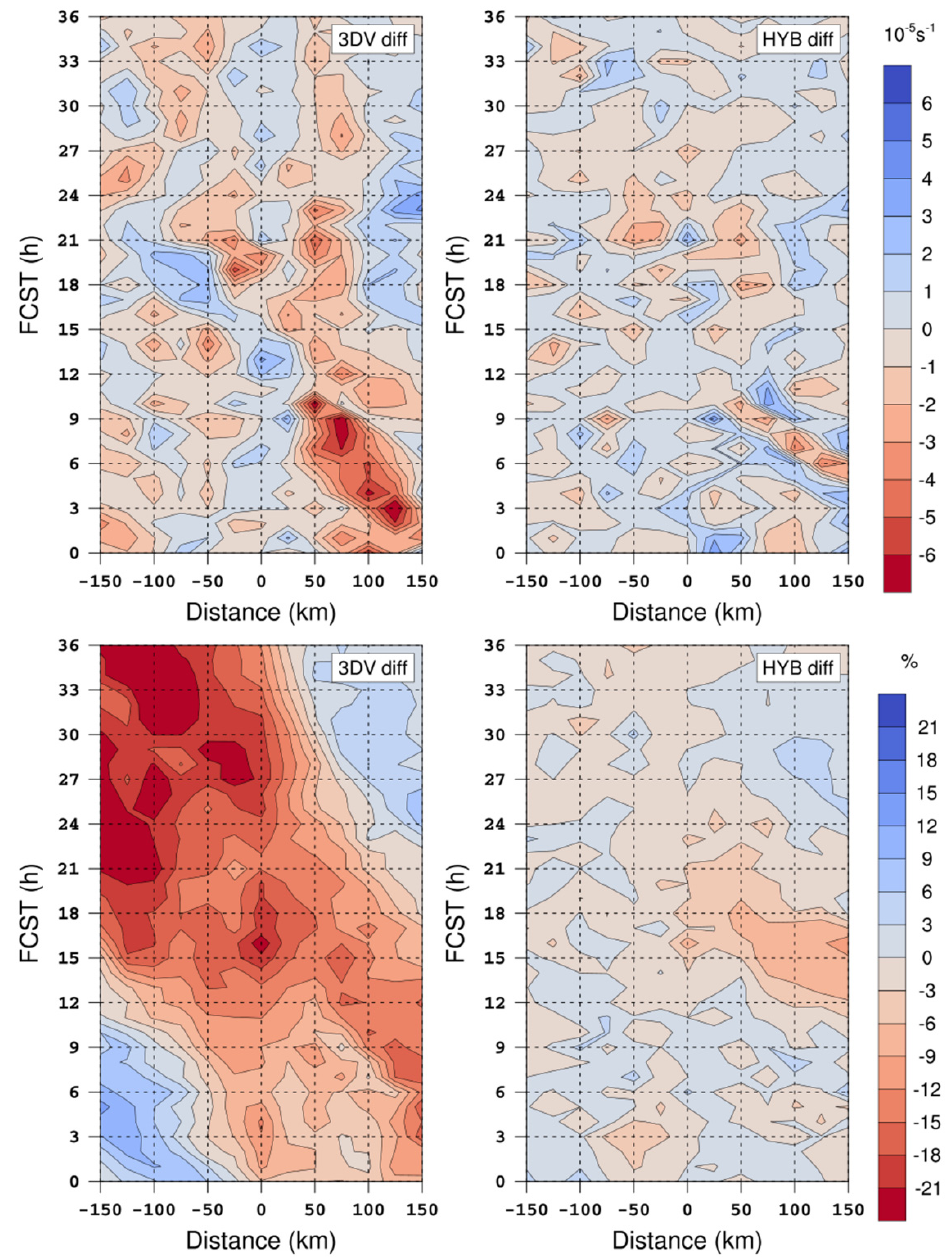
Figure 12. Hovmöller diagrams of 850-hPa differences in convergence (10 − 5 s − 1 , above) and relative humidity (%, below) in the 3DV and HYB experiments during Case 5 with CTL simulations subtracted, averaged in the solid black transect shown in Figure 2.